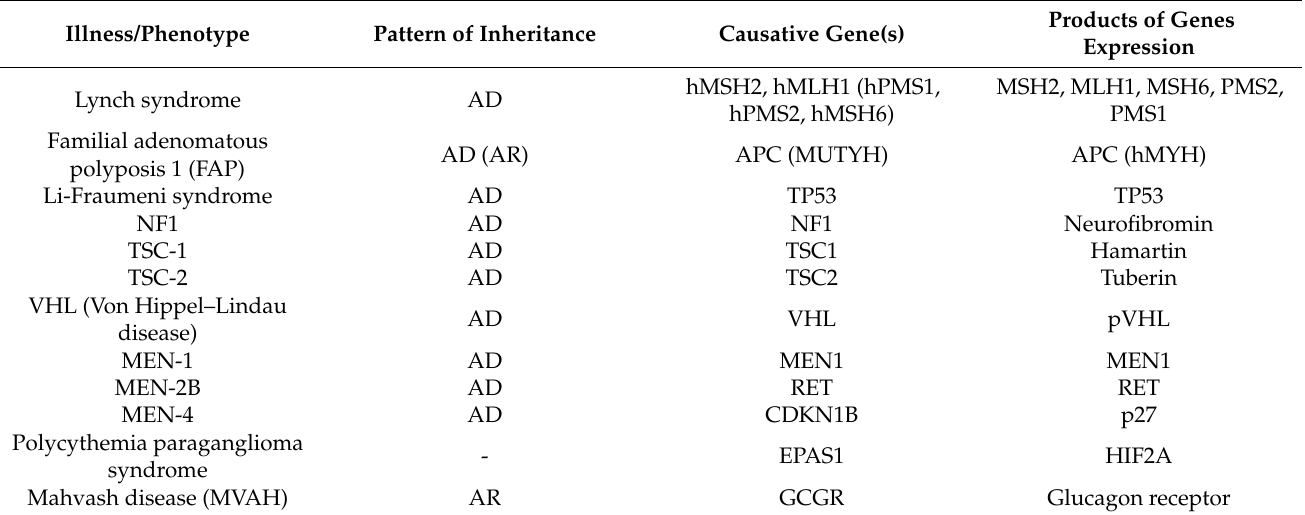
Table 2. Selected genetic diseases associated with gastroenteropancreatic neuroendocrine neoplasms